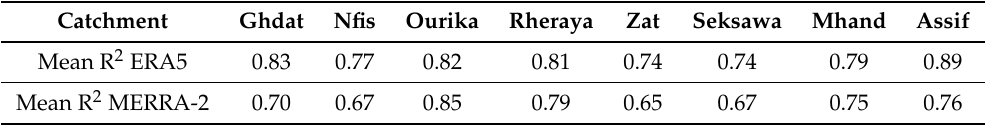
Table 3. Mean R 2 scores from 2000 to 2018 between modeled and observed SCF for each sub- catchment area of